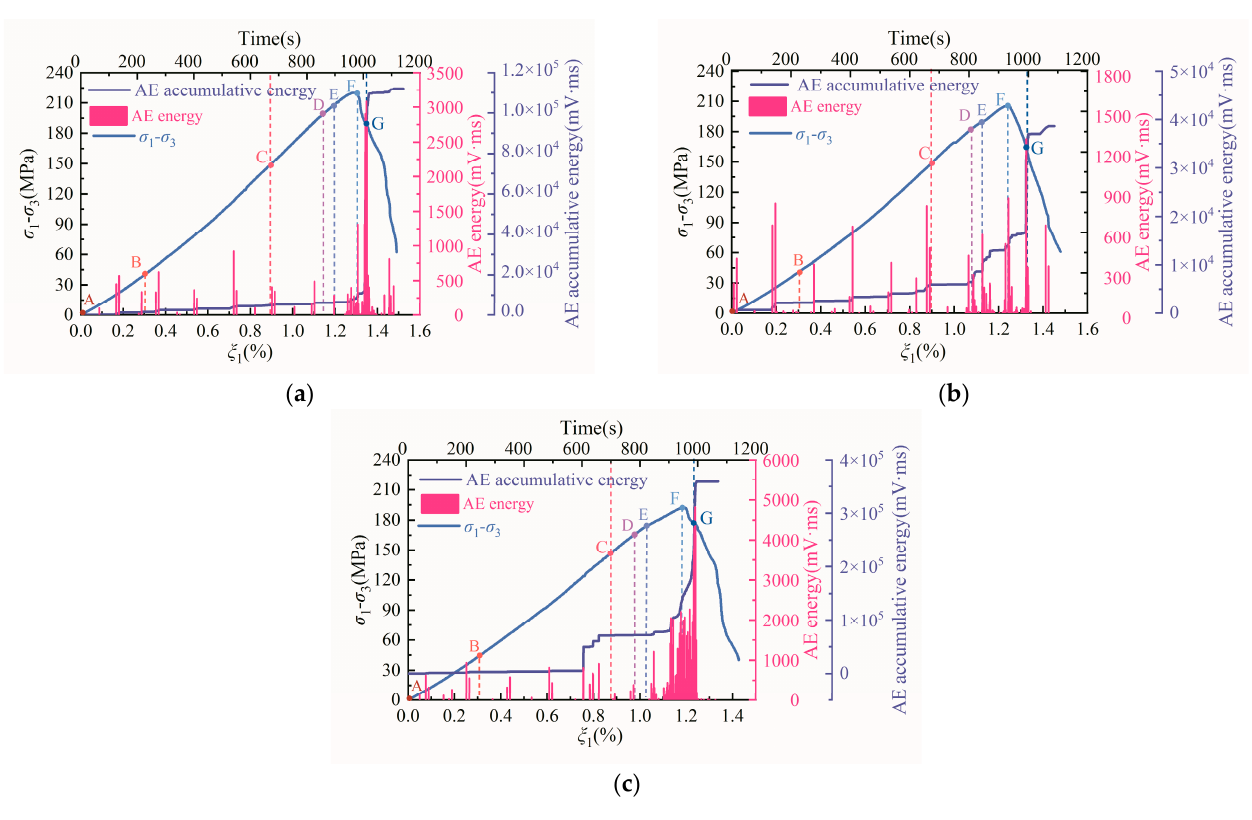
Figure 11. Evolution curves of AE energy and cumulative AE energy for diorite under different unloading confining-pressure rates: ( a ) 0.008 MPa·s − 1 , ( b ) 0.016 MPa·s − 1 , and ( c ) 0.032 MPa·s − 1 . Note: